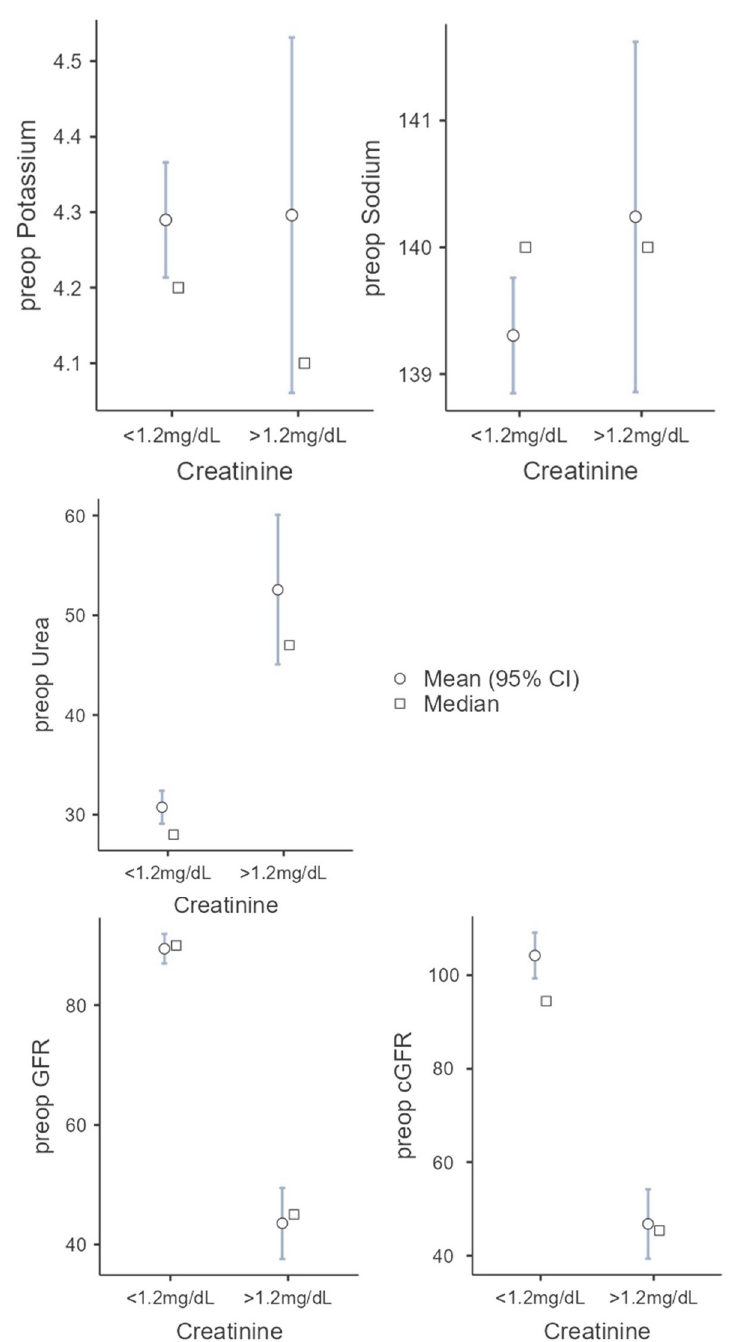
Figure 2. Comparison of the two groups (serum creatine cut-off 1.2 mg/dL) regarding the following parameters: potassium, sodium, urea, GFR, and cGRF. parameters: potassium, sodium, urea, GFR, and